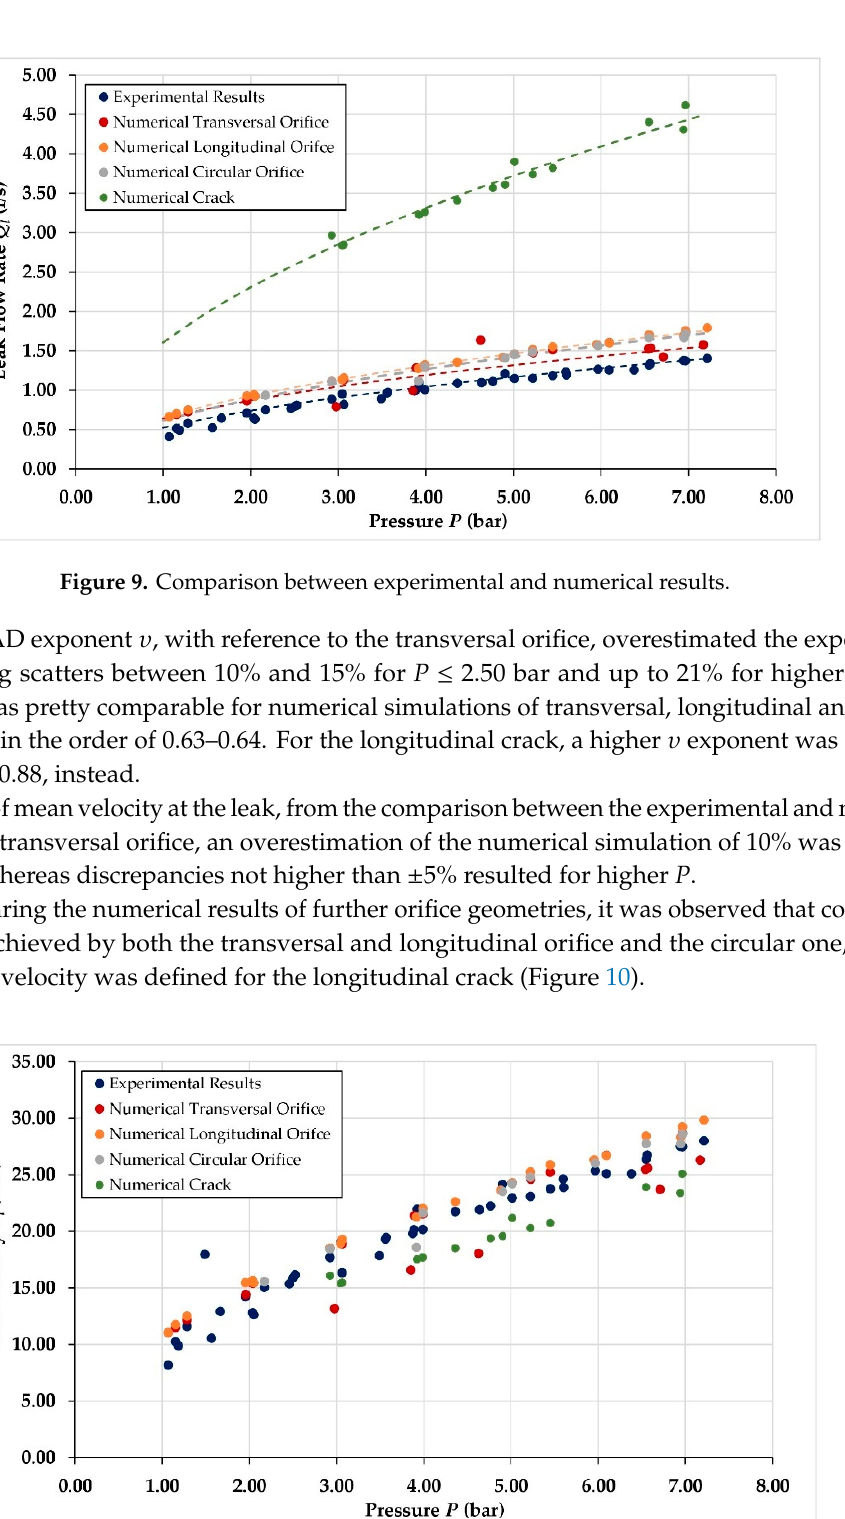
Figure 10. Leak velocity comparison between experimental data and numerical simulations.